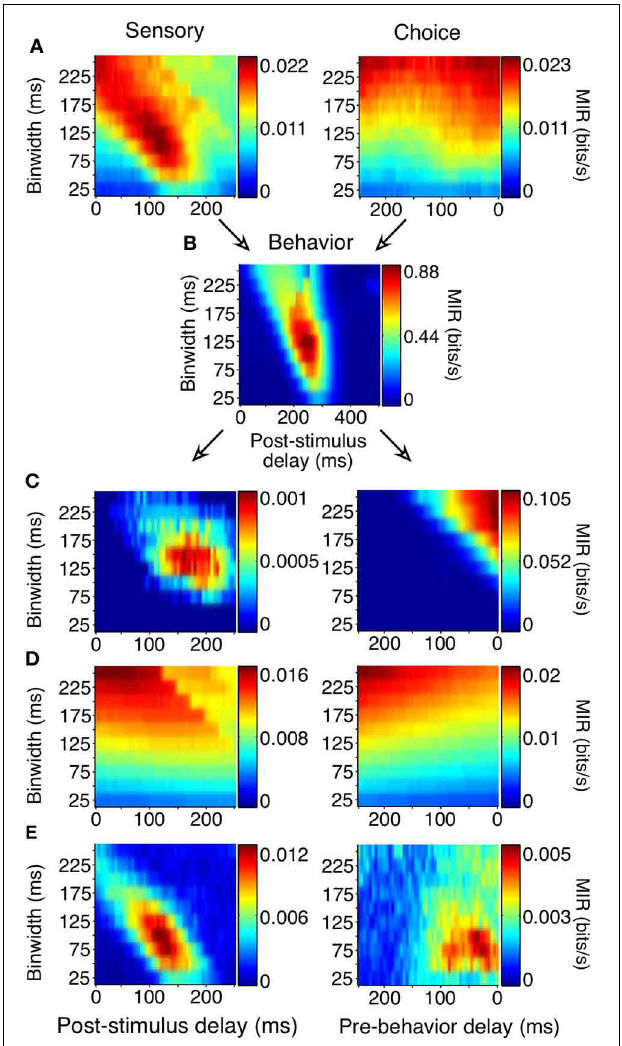
FIGURE 5 | Generation of sensory and choice surfaces. For each combination of delay and binwidth, the relationship between the two variables of interest was tabulated across all trials (as in Figure 4 ). Each of these contingency tables was used to calculate the MIR, and a single corresponding point on the surface was colored accordingly (A,B) . The sensory information surface predicted solely by the covariance of choice information with the animal’s behavior, and the choice surface predicted based solely by the covariance of sensory information with the animal’s behavior were computed so that covariance could be accounted for (C) . Because each point on the surface was potentially based on a different number of observations, an estimate of bias was also obtained for each delay and binwidth through a bootstrapping procedure (D) . Due to the limited length of stimulus presentation and short reaction times, sampling decreased as binwidth and delay increased; this decrease in sampling increased the bias. The final surfaces (E) represent the information remaining after the covariance and bias for each point had been subtracted. All surfaces shown here represent the average across all 178 units.